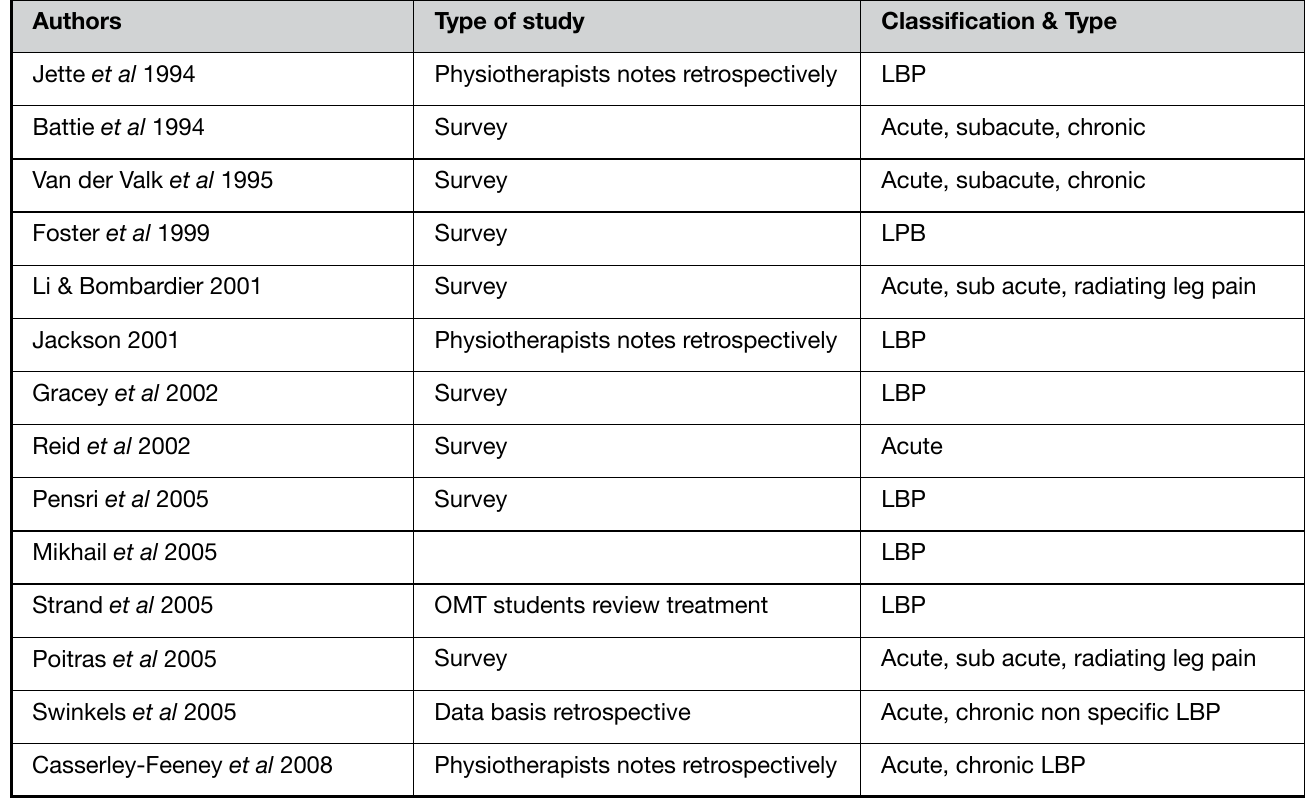
Table 1. Studies included for review.